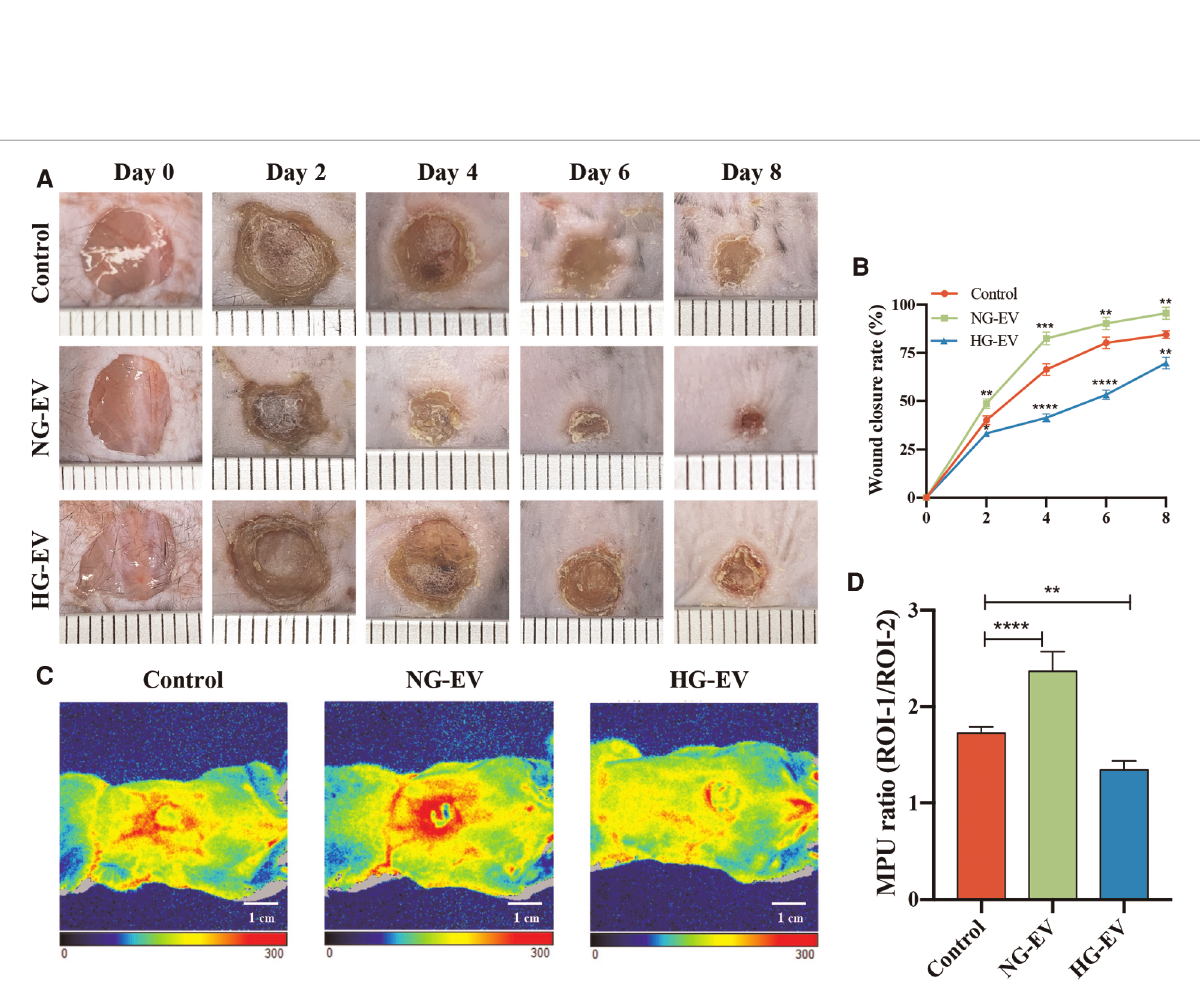
FIGURE 5 The impact of EVs on cutaneous wound healing and blood perfusion. ( A ) Healing progression of the wound from day 0 to day 8. ( B ) The statistical analysis of wound closure area in each group ( n =5). ( C ) The blood fl ow at the wound site in each group that was evaluated by laser Doppler perfusion imaging system. ( D ) Quantitative perfusion intensity of the wound area in the three